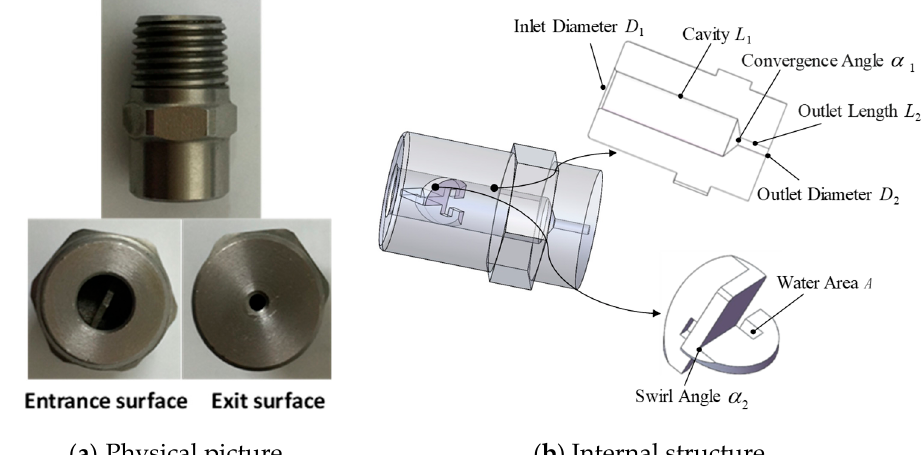
Figure 1. Distributor pressure nozzle.